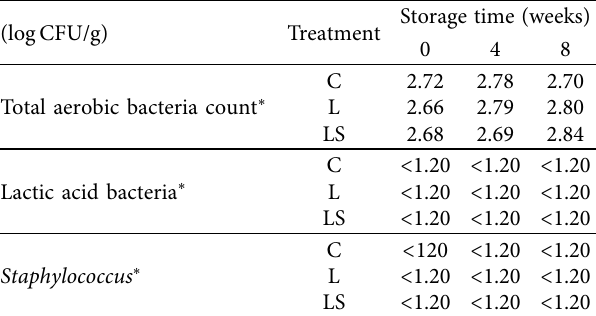
∗ No statistically significant differences were found ( P > 0 . 05). C: control treatment, quantity added NaNO 2 100mg/kg; L: quantity